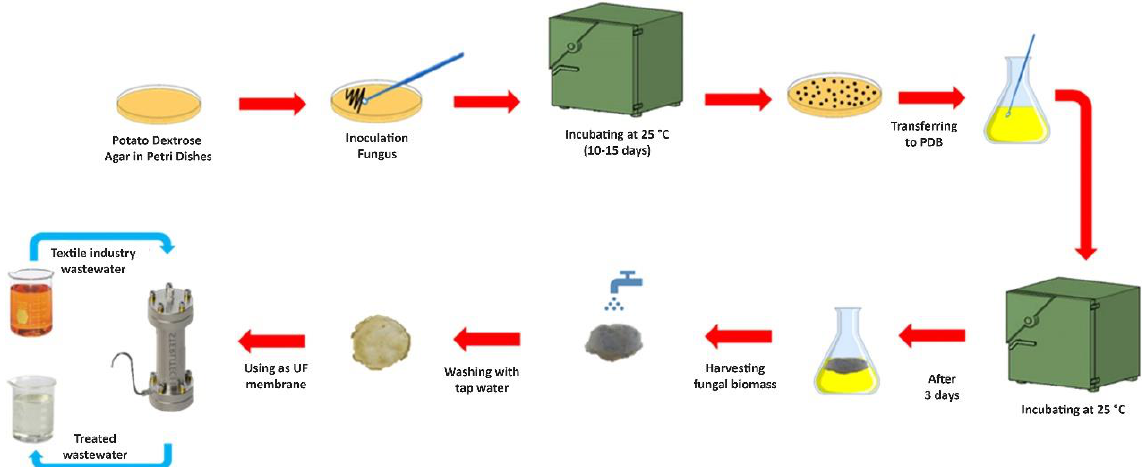
Figure 1. The preparation procedure of a bioactive ultrafiltration membrane. Reprinted with permission from [83] . Copyright © 2019, Elsevier.